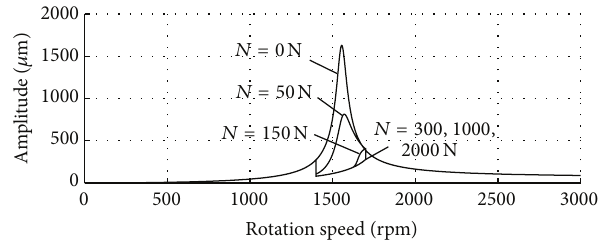
Figure 6: The amplitude-frequency diagram of the rotor under different pressing forces applied during the critical speed region (1400 ∼ 1700 rpm).